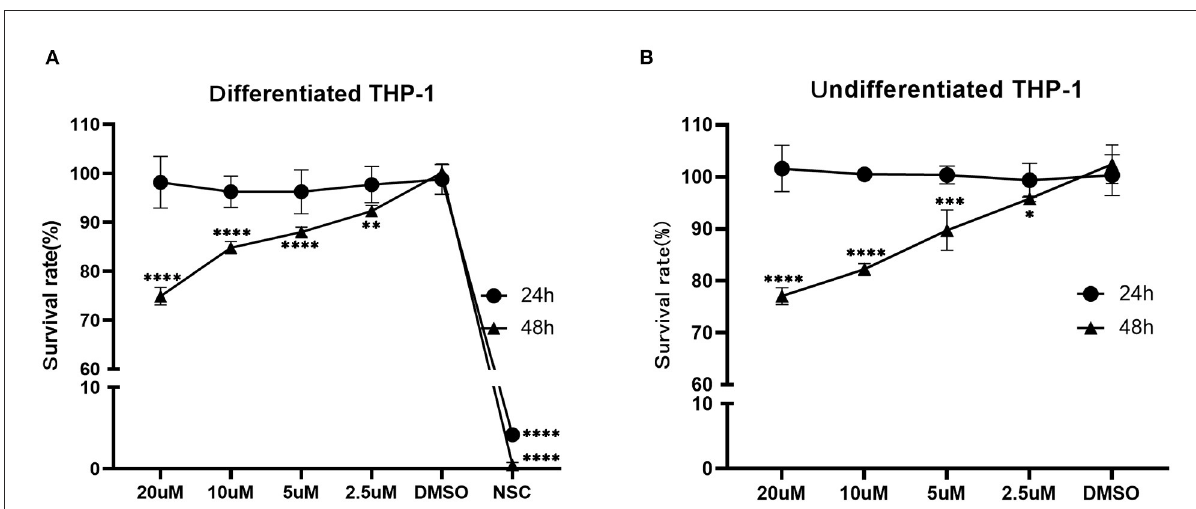
FIGURE5 Cytotoxicity assay of NOS in the differentiated (A) and undifferentiated (B) THP-1 cell lines. DMSO group: the negative control; NSC 228155 group: the positive control (at a final concentration of 2.5 µ M). All data are shown as the means ± SD ( n = 3). * P < 0.05; ** P < 0.01; *** P < 0.001; **** P <